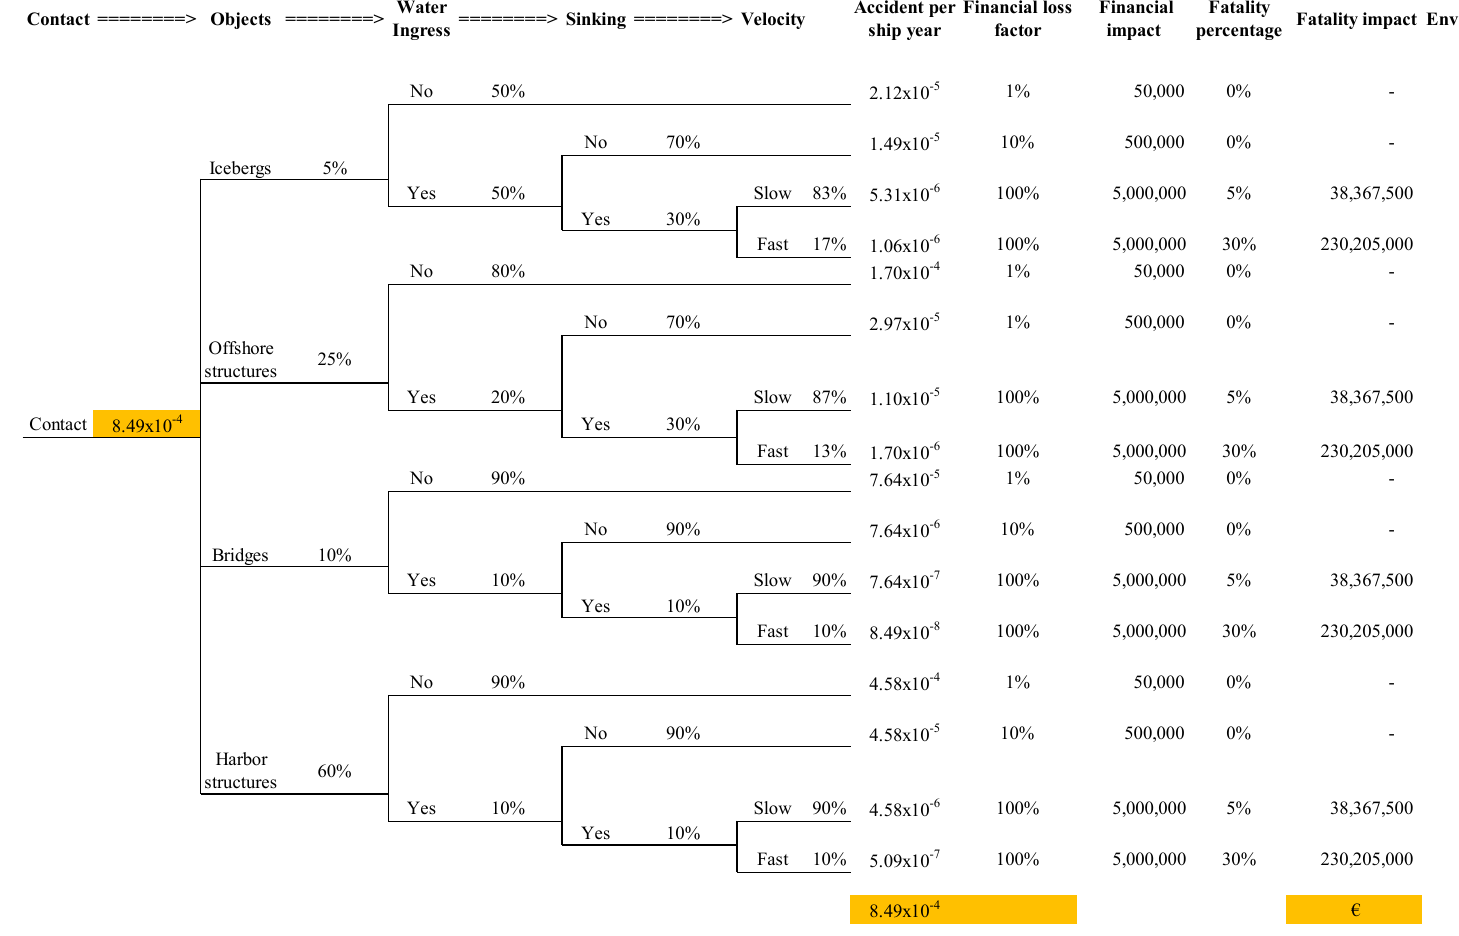
Figure 18. Event tree analysis of contact for the ferry in this